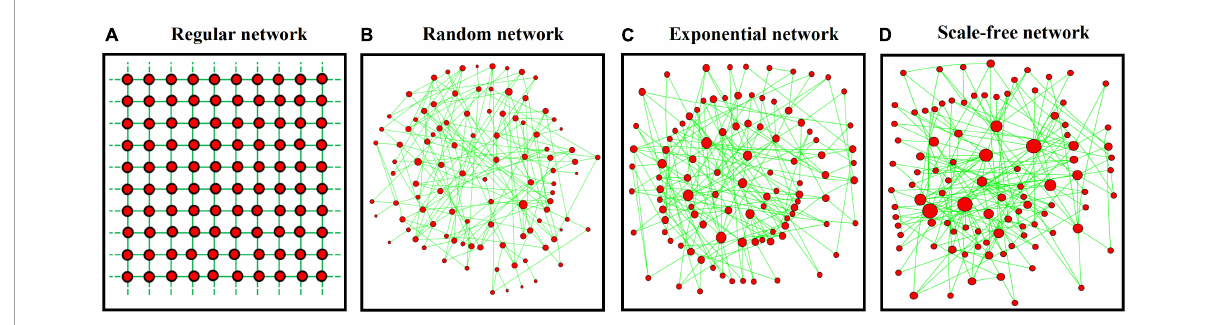
FIGURE1 Four typical network structures consisting of 100 patches (red nodes) with 200 links (green lines): (A) lattice-structured regular, (B) randomly connected, (C) exponential, and (D) scale-free networks. Variation in patch degree (proportional to node size) increases from left to right panels.